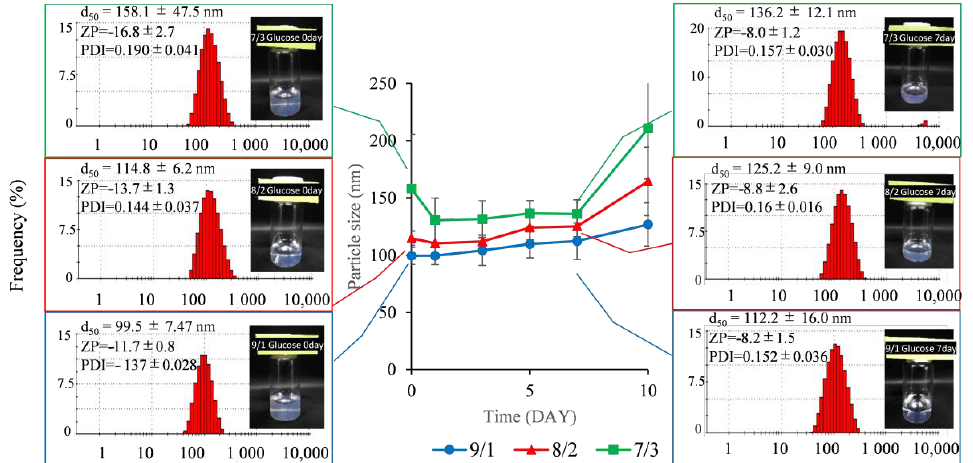
Figure 4. Changes in particle size and zeta potential of nanoparticles of Sol/ASC-DP at mixing ratios of 9/1, 8/2, and 7/3 after storage at 25 °C from day 0 to day 10 in saline. Zeta potential is presented as mean ± S.D. ( n = 3).